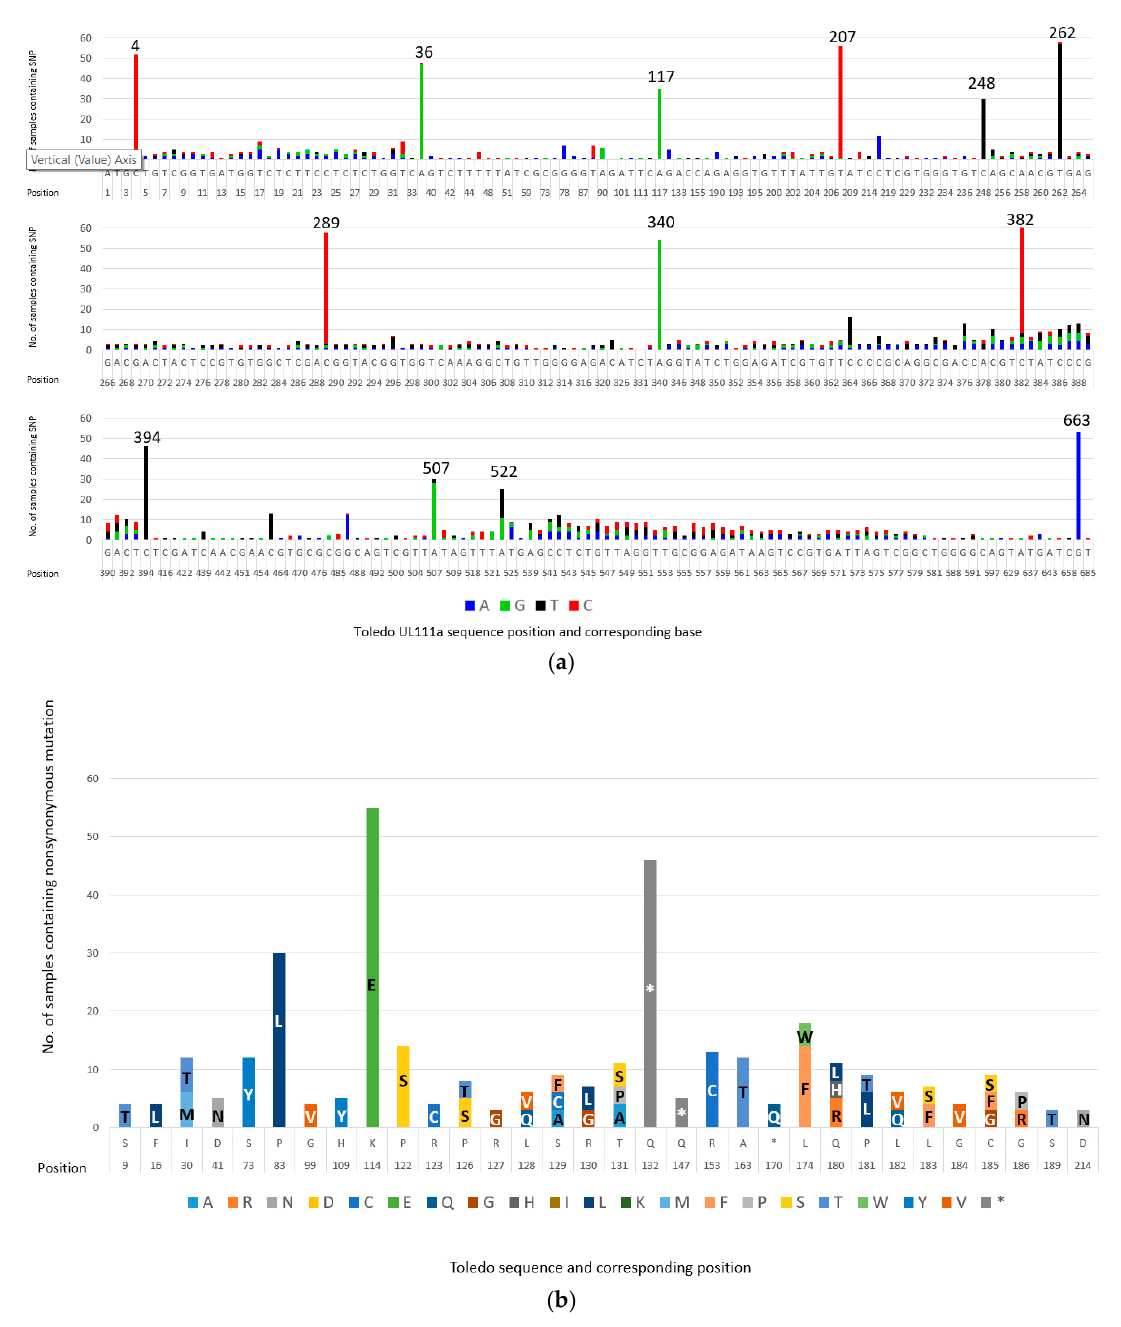
Figure 1. ( a ) Summary of all nucleotide variations identified in HCMV sequenced in 59 samples. Variations are displayed in reference to HCMV Toledo strain. Blue bars represent A, green bars represent G, black bars represent T, and red bars represent C. The height of the bars represents the number of samples the variation was found; ( b ) Summary of all nonsynonymous mutations identified in HCMV sequenced in 59 samples. Variations are displayed in reference to HCMV Toledo strain. Amino acids are represented by their one-letter codes. Each variation presented was found in at least 3 samples. The height of the bars represents the number of samples in which the variation was